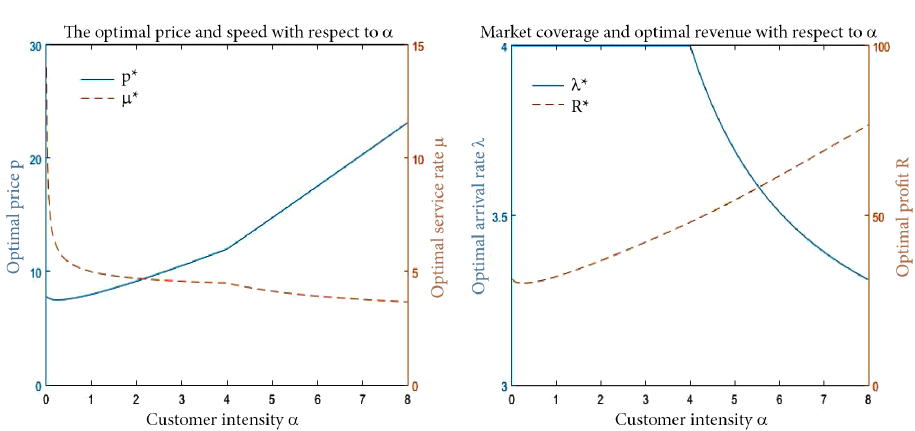
Figure 1. The left panel illustrates the optimal service rate and price with respect to the customer intensity a . The right panel illustrates the arrival rate in equilibrium and the optimal revenue with respect to a